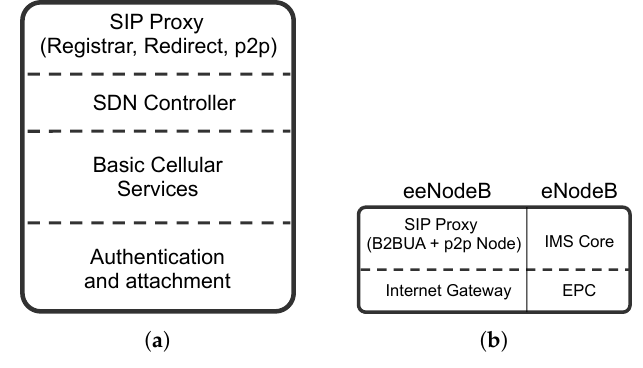
Figure 6. Node functionalities. ( a ) SN; ( b )